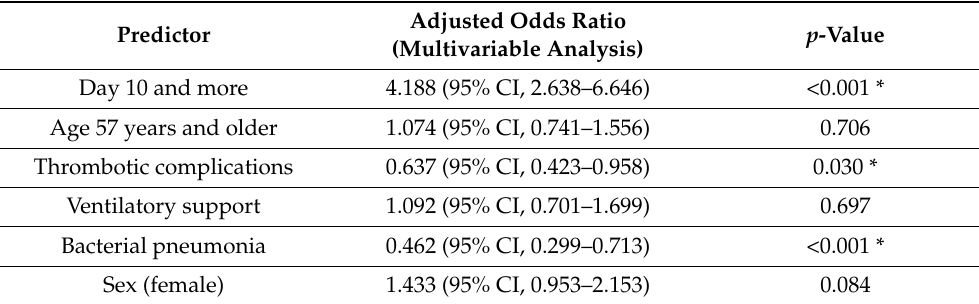
Table 7. Multivariable regression analysis: independent predictors of increased mean optical density (above 0.43) in arteriolar endothelium (with adjusted odds ratio calculation).